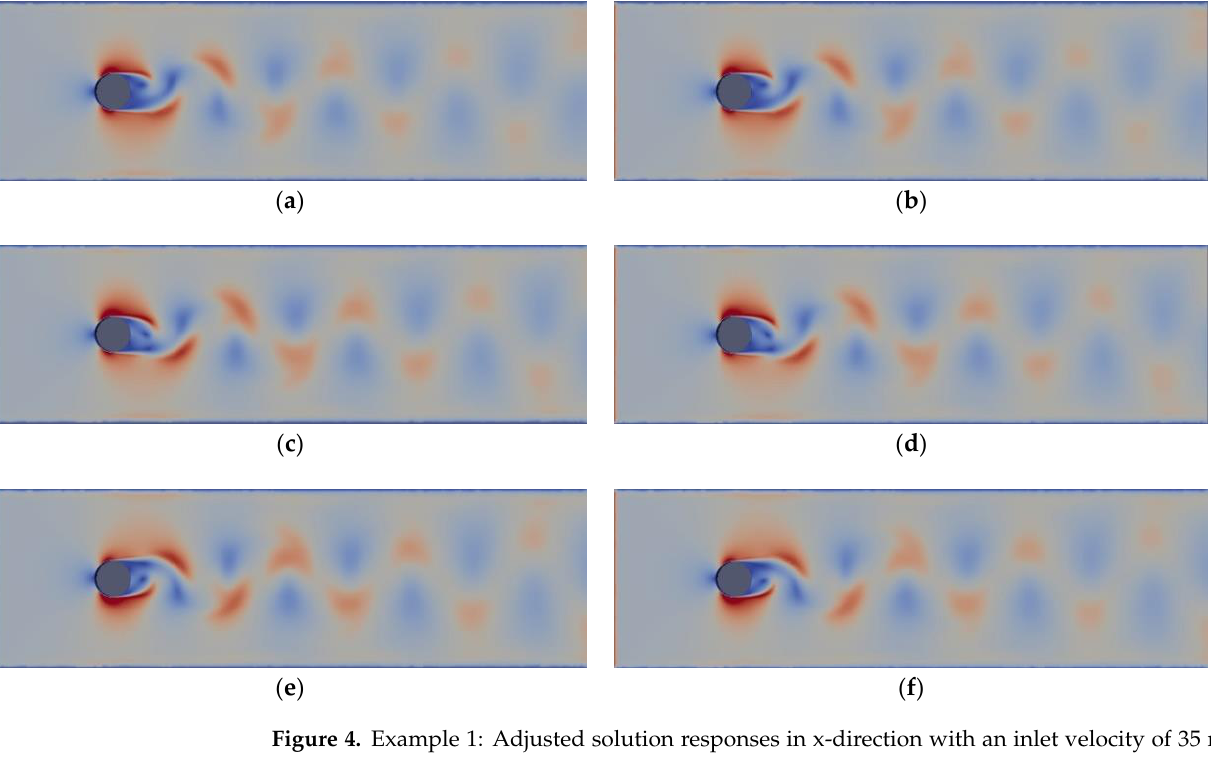
Figure 4. Example 1: Adjusted solution responses in x-direction with an inlet velocity of 35 m/s: ( a ) ROM at t = 4.0016 s; ( b ) OpenFOAM at t = 4.0016 s; ( c ) ROM at t = 12.0002 s; ( d ) OpenFOAM at t = 12.0002 s; ( e ) ROM at t = 24.0712 s; ( f ) OpenFOAM at t = 24.0712 s.